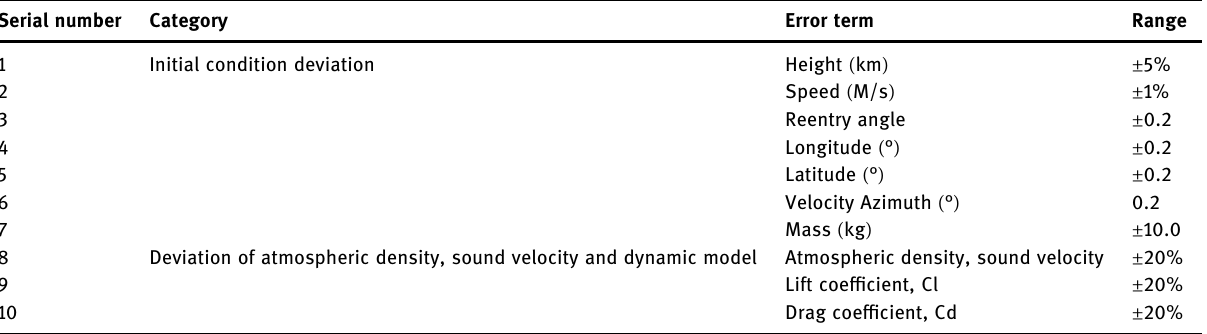
Table 1: Error source setting ( for module separation point